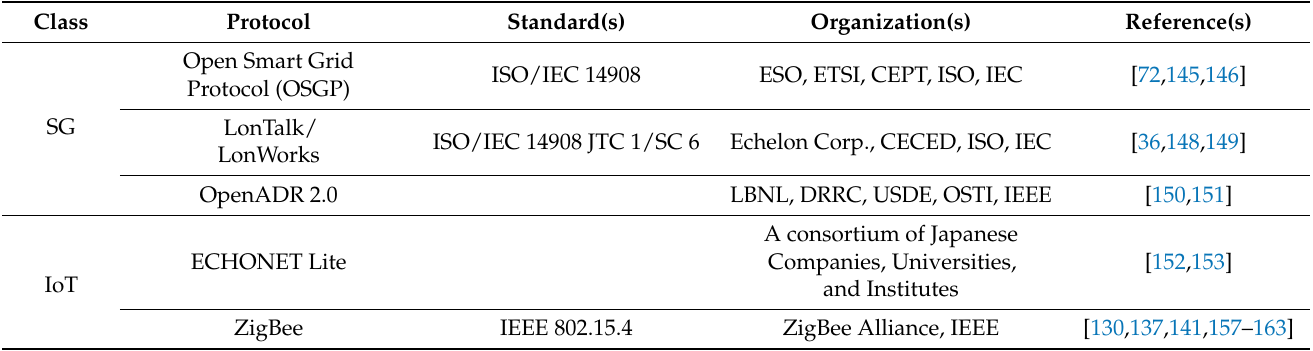
Table 4. SG and IoT communication